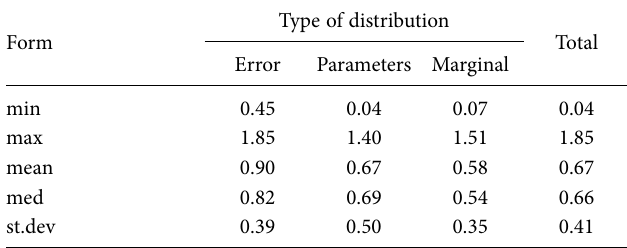
Table 2. Summary statistics of IRSF across distribution types.